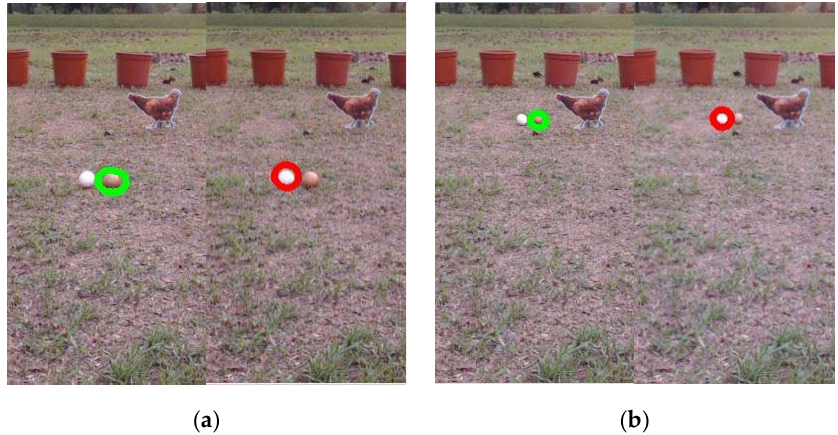
Figure 9. Egg recognition results for different positions: ( a ) 85 cm; ( b ) 105 cm.